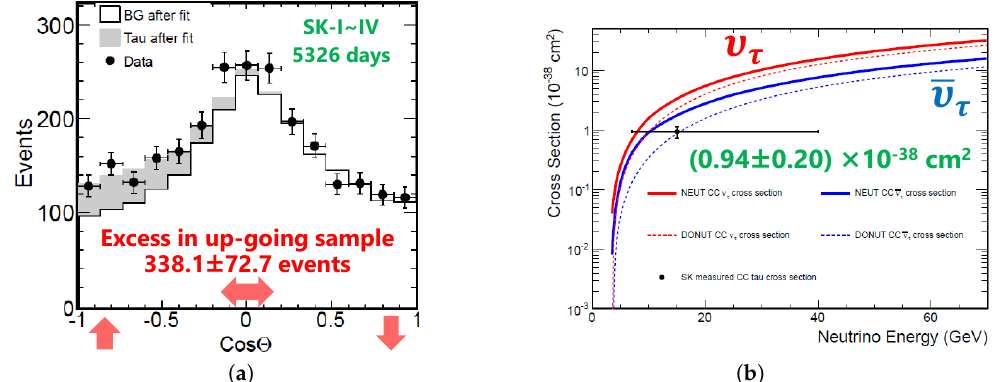
Figure 3. ( a ) The zenith angle distribution of the τ -like events. The tau signal drawn in gray is clearly seen over the background in up-going event. ( b ) The cross-section of ν τ CC measured by this analysis. The original figures are adapted from Ref.